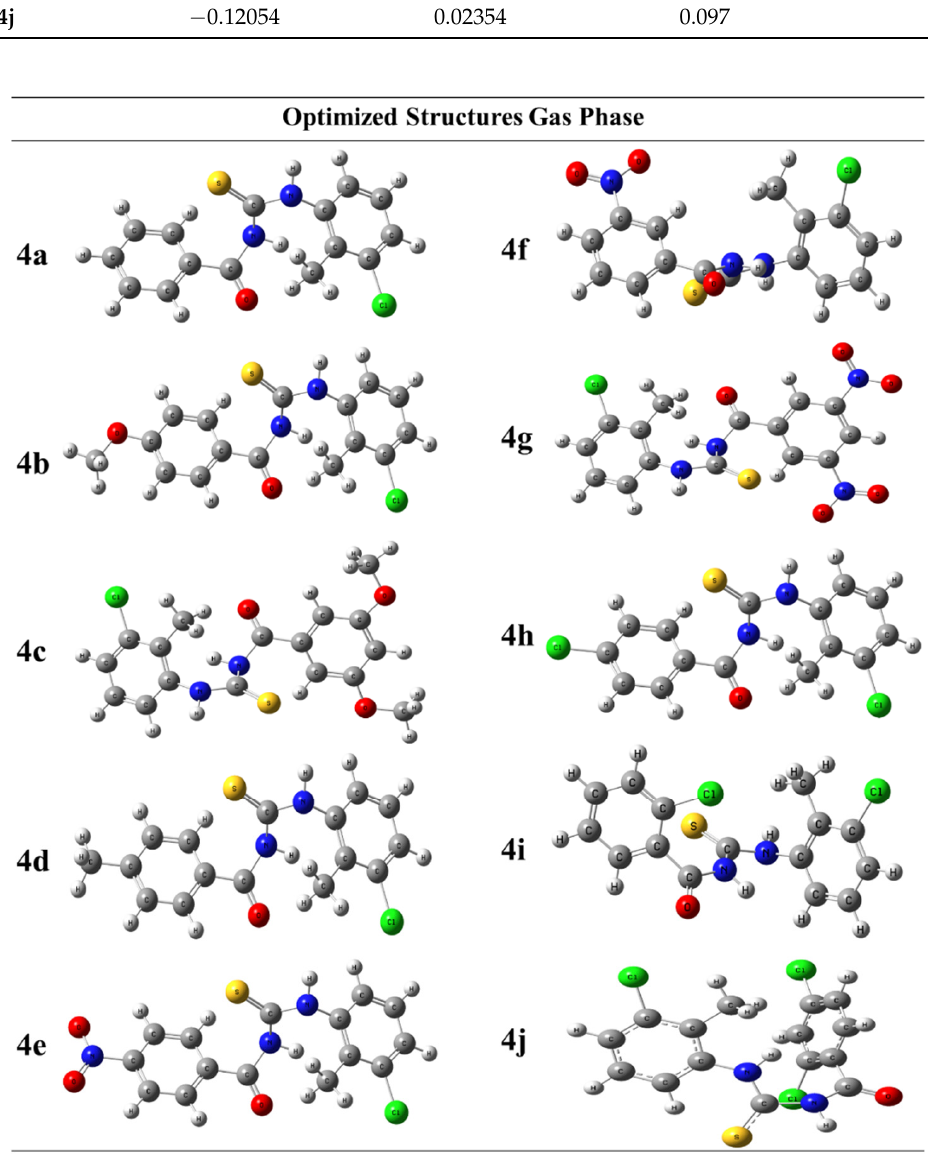
Figure 11. Showing optimized molecular structures of 1-aroyl-3-[3-chloro-2-methylphenyl]thiourea hybrids [ 4a – j ].